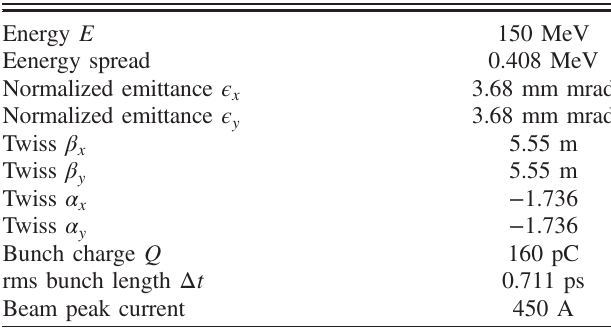
TABLE IV. Electron beam parameters used for the simulation. The Twiss parameters are given at the linac exit.